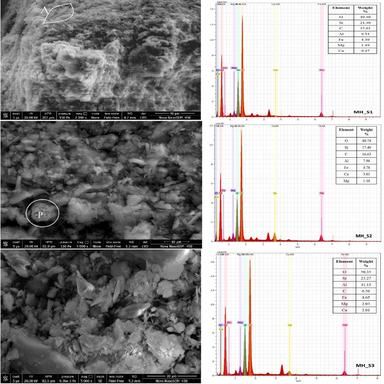
FESEM and EDX characteristics of MH basin sediment samples.